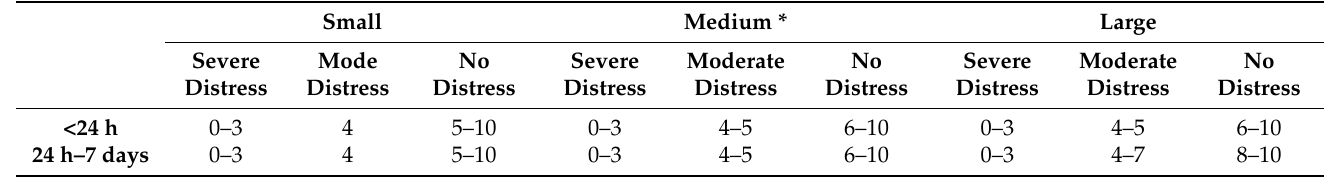
Table 10. Redefinition of viability classes according to detected Apgar-score cutoff values. Small Medium *